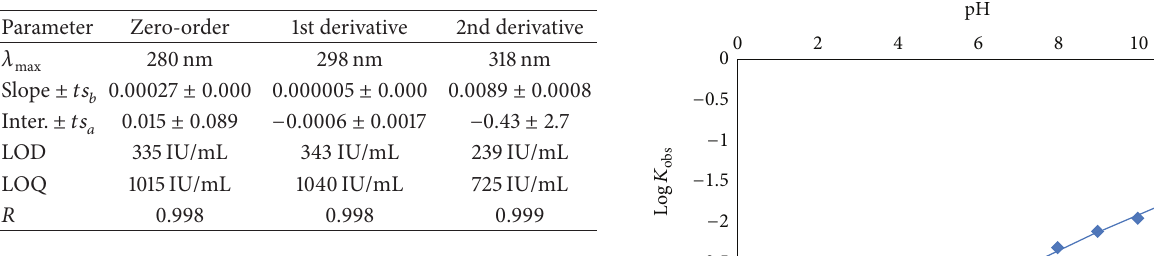
Table 1: Linearity data for the developed methods.